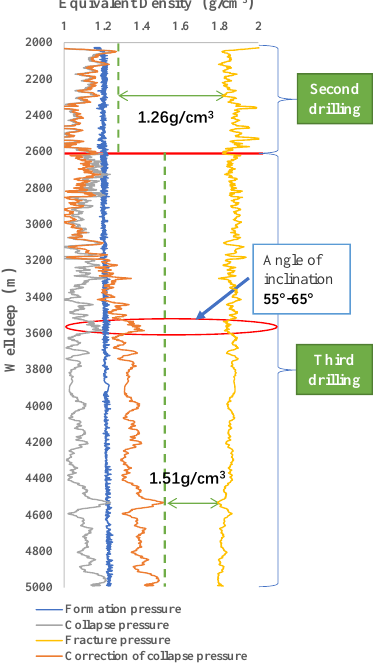
Figure 10. Corrected safe drilling fluid density window.